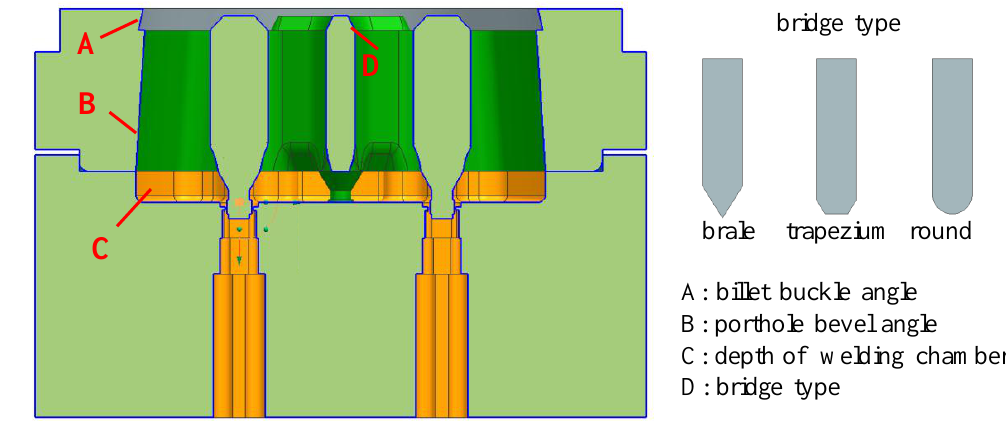
Figure 6. The selected die feature for control factors of Taguchi method. Table 1. Control factors and levels of die configurations used in the Taguchi method.